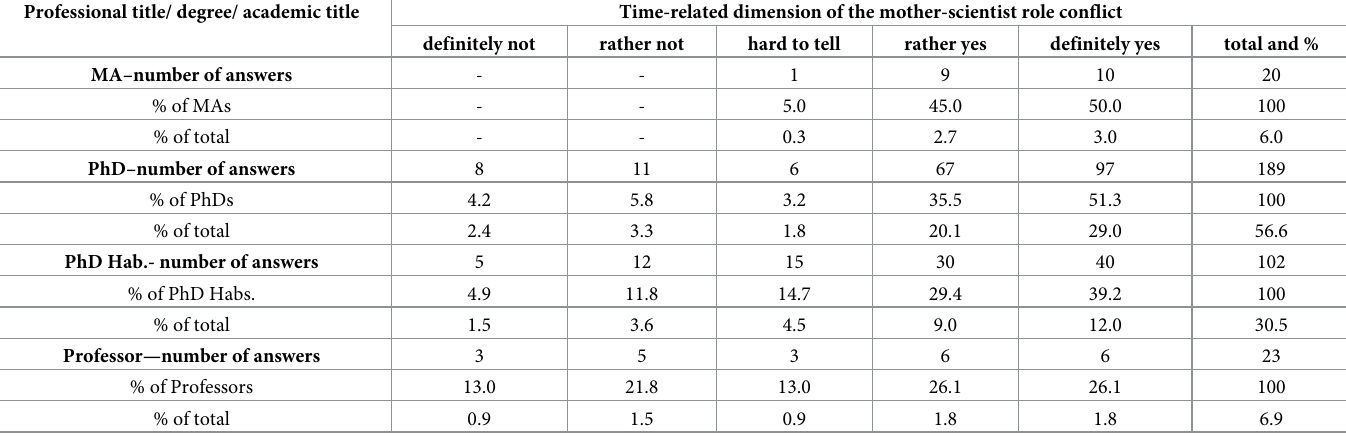
Table 11. Time-related dimension of the mother-scientist role conflict by professional title/degree/academic title. Source: Study by Ewa